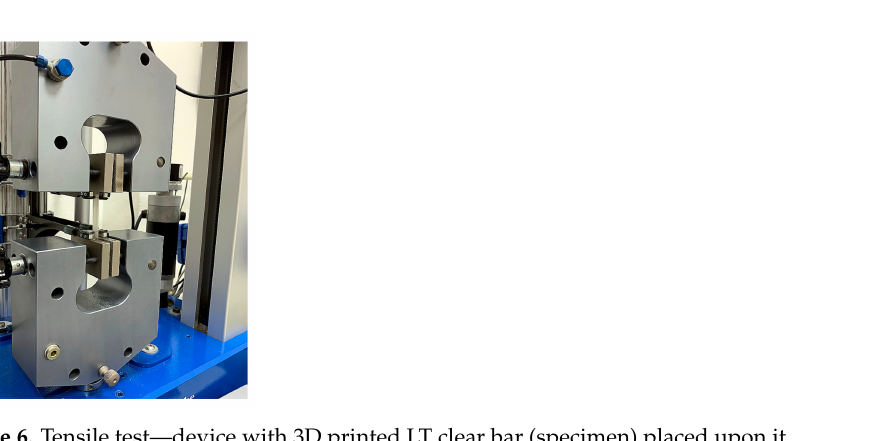
Figure 6. Tensile test—device with 3D printed LT clear bar (specimen) placed upon it.